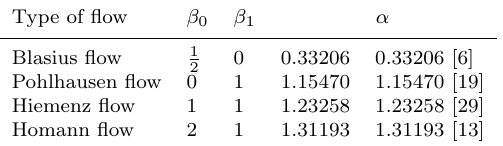
Table 4. The wall shear stress α = f (cid:48)(cid:48) (0) of Falkner-skan models compared to different benchmark solutions. Type of flow β 0 β 1 α